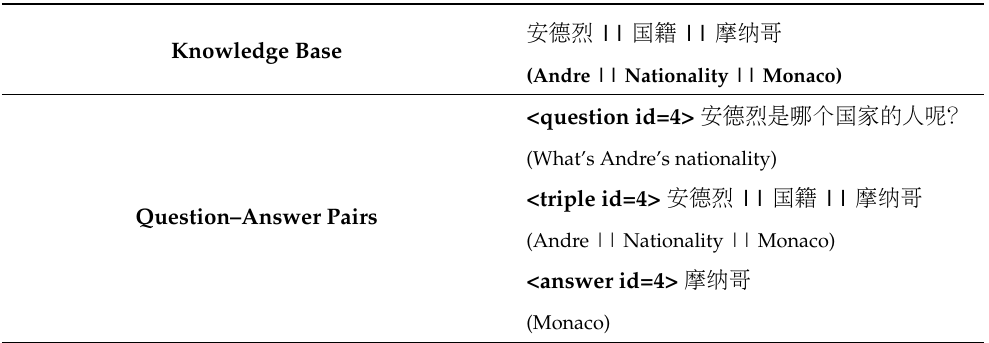
Table 1. Sample data from the NLPCC2016 dataset. The upper part is the sample of triple in the knowledge base. The second part is the sample of the question–answer pair.